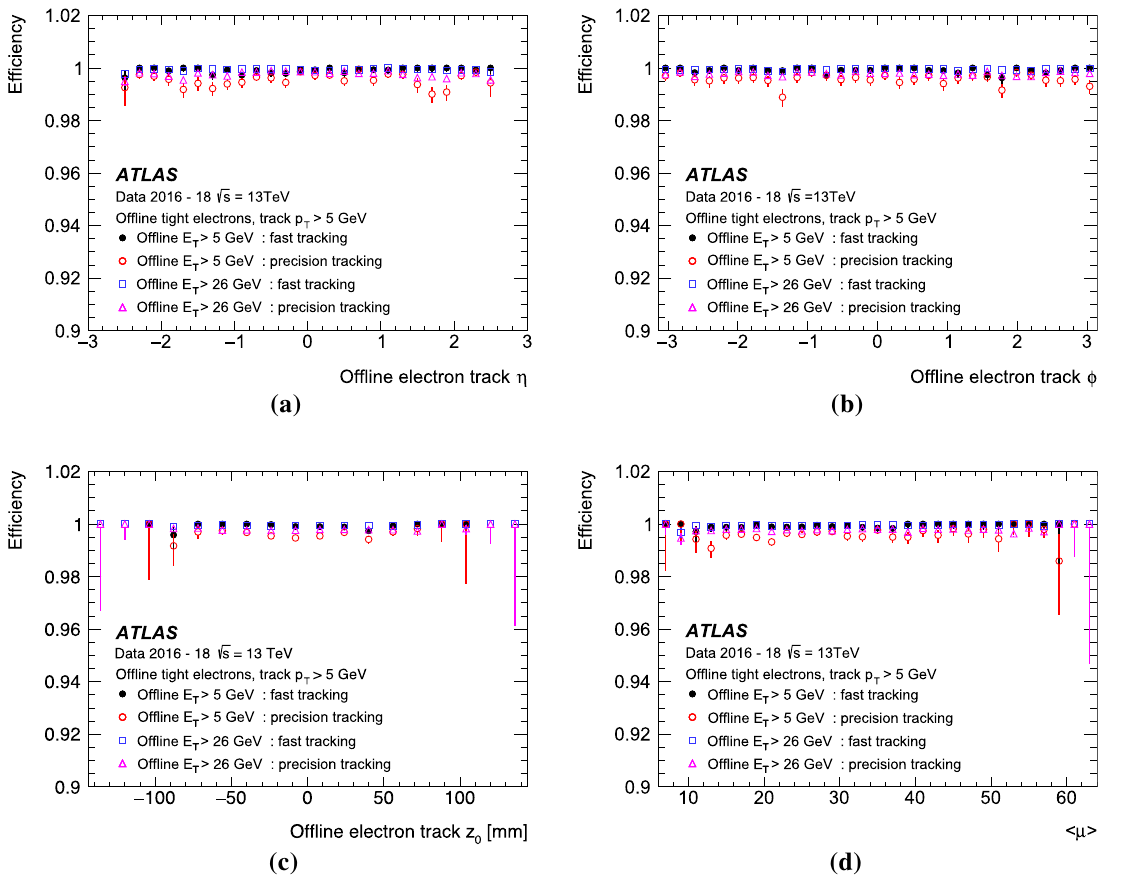
Fig. 23 The ID trigger tracking efficiency for electrons selected by the 5GeV and 26GeV electron triggers, with respect to offline electron candidates with E T > 5GeV for the 5 GeV trigger and E T > 26GeV for the 26 GeV trigger. The efficiency is shown as a function of a the offline reconstructed electron track η , b the offline reconstructed elec-